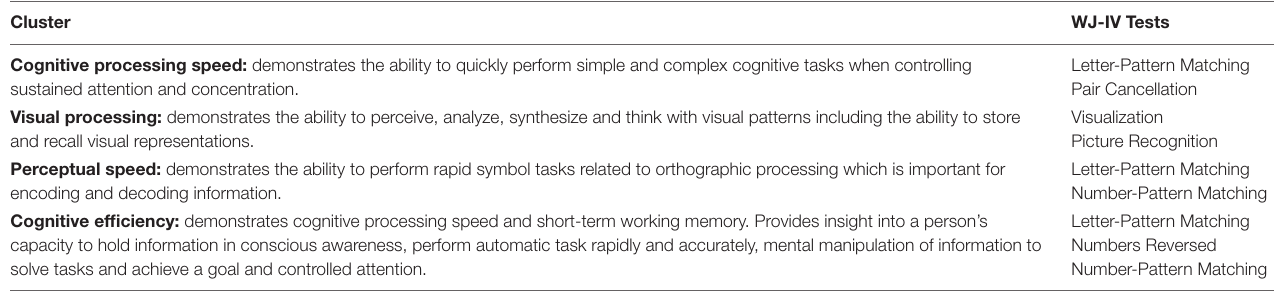
TABLE 3 | WJ-IV cluster scores and corresponding aggregate